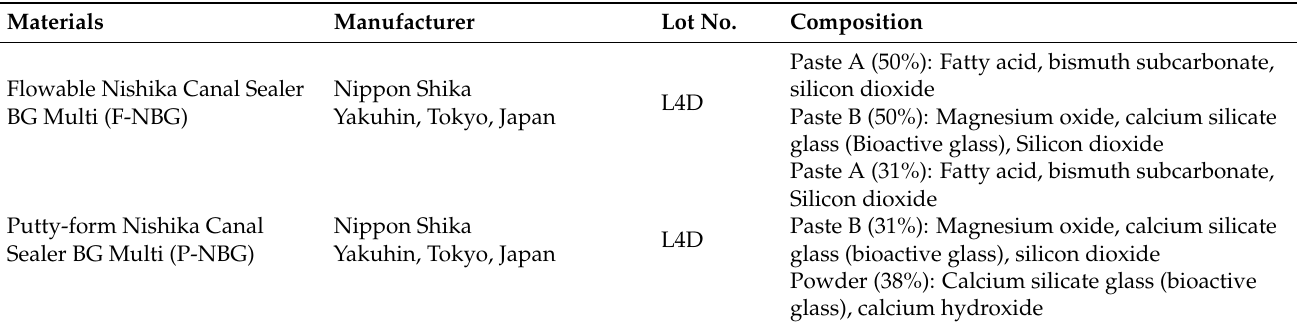
Table 1. Materials used in this